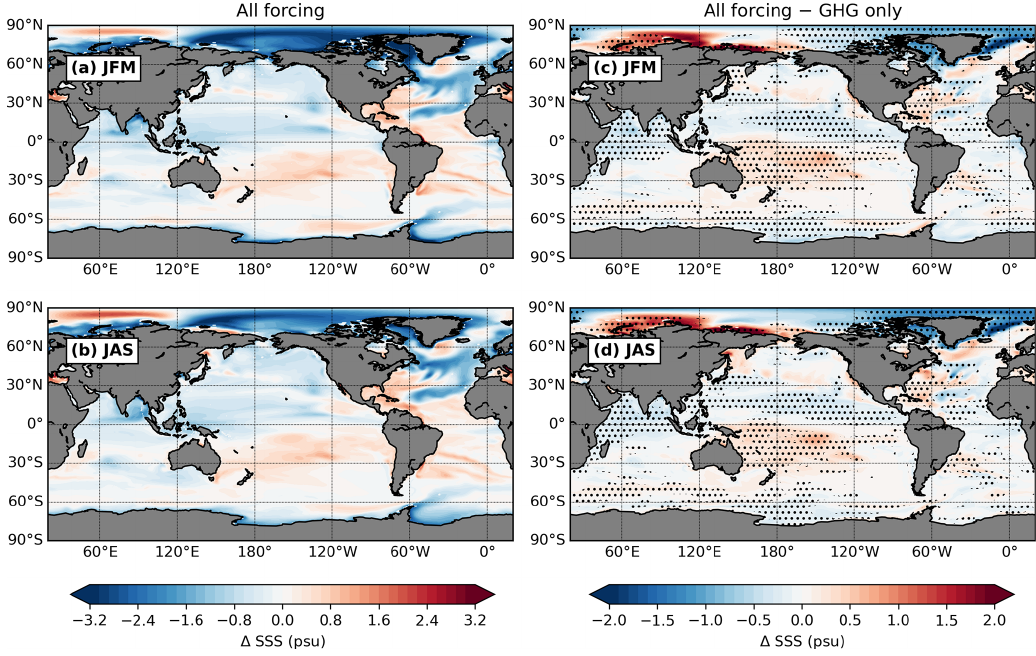
Figure 10. Same as Fig. 9 but for the SSS